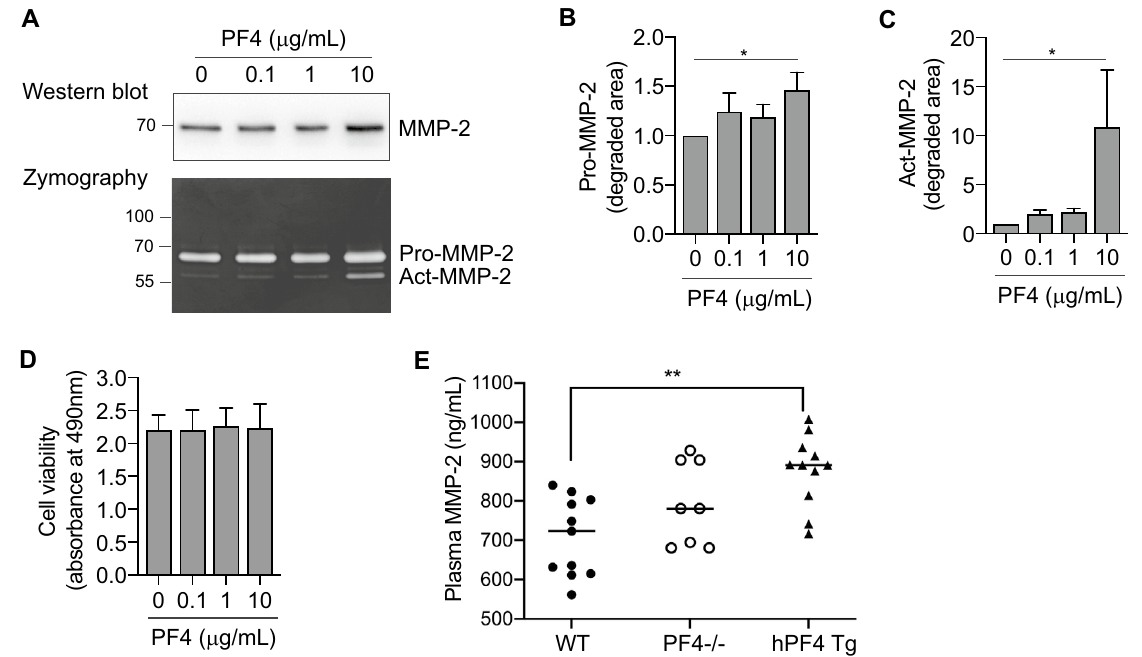
Figure 1. PF4 promotes the secretion of MMP-2. ( A ) Serum-starved human gingival fibroblasts (hGFs) were cultured for 24 h in the presence or absence of recombinant PF4 at the indicated concentrations. Cell culture supernatants were collected, resolved by SDS-PAGE, probed for MMP-2 (immunoblot, top panel), and also analyzed by gelatin zymography (bottom panel). ( B )-( C ) . Bar graphs depict gelatin degradation by pro-MMP-2 ( B ) and active MMP-2 ( C ), as quantified using ImageJ software. The gelatin-degraded area of the untreated samples (0) was set at 1. Data are mean ± SD and represent three independent experiments. *, p < 0.05, based on one-way ANOVA and Tukey’s multiple post-hoc comparison tests. ( D ) Bar graph confirming cell viability (as measured by the MTS assay) in the presence of recombinant PF4 at the indicated concentrations for 48 h. ( E ) Scatter plots represent levels of MMP-2 in plasma obtained from wild-type mice ( WT , black circles), PF4-null mice ( PF4 -/- , open circles) and WT mice expressing the human PF4 transgene ( hPF4 Tg, black triangles). Data are mean ± SD and represent three independent experiments. **, p < 0.001 based on one-way ANOVA and Tukey’s multiple comparisons test.